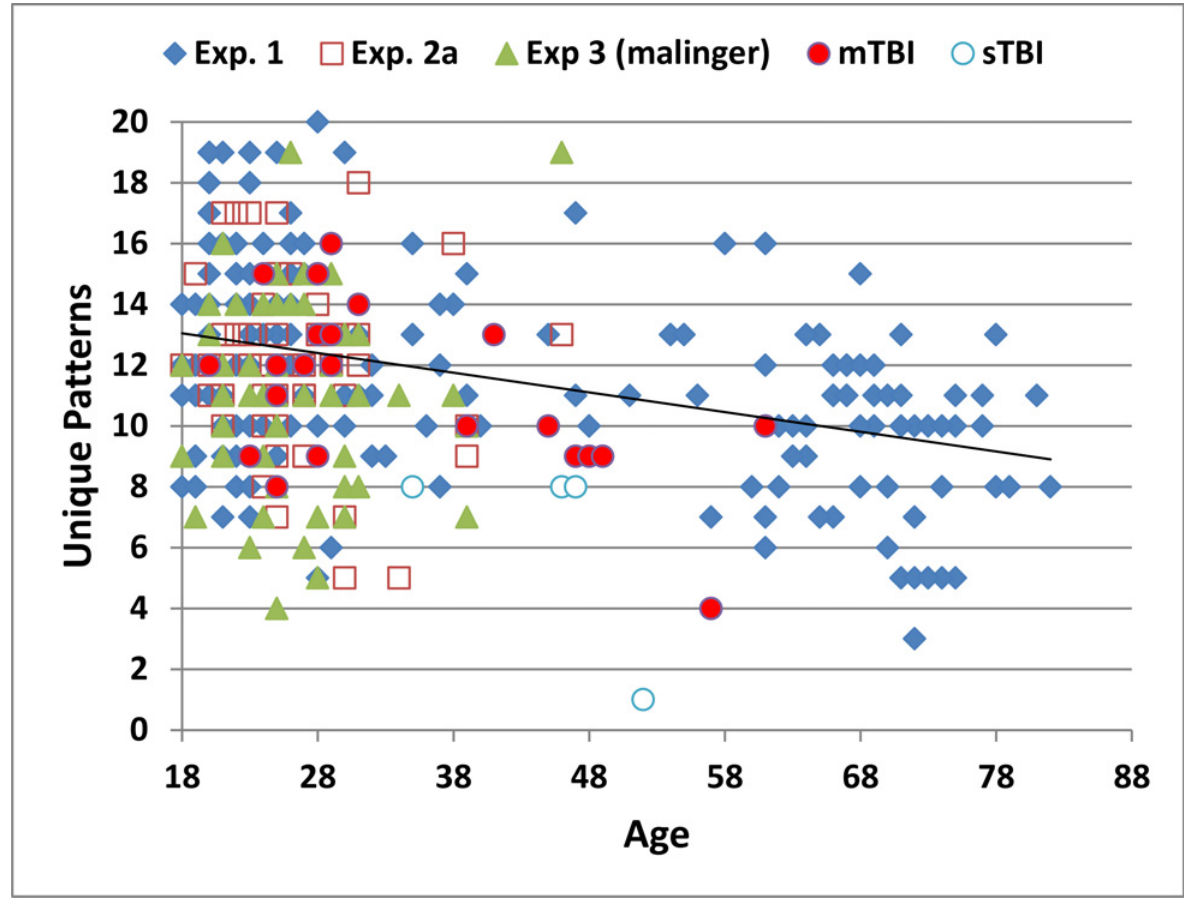
Fig 2. The number of unique patterns produced in 90s as a function of participant age. The age-regression slope from Experiment 1 (blue diamonds) is shown, along with the results from the first test session of Experiment 2 (2a, open red squares), Experiment 3 (simulated malingering, green triangles), and Experiment 4 shown separately for patients with mild TBI (mTBI, filled red circles), and severe TBI (sTBI, striped red circles).